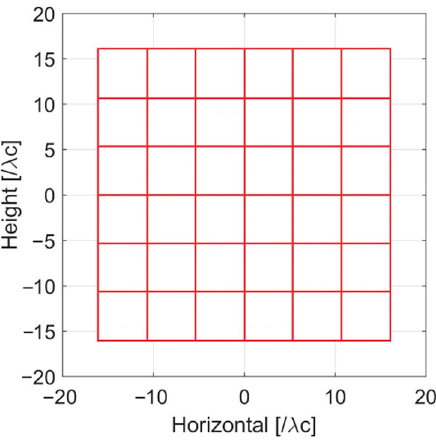
Figure 2. The 2D observation aperture divided into 6 × 6 grids.